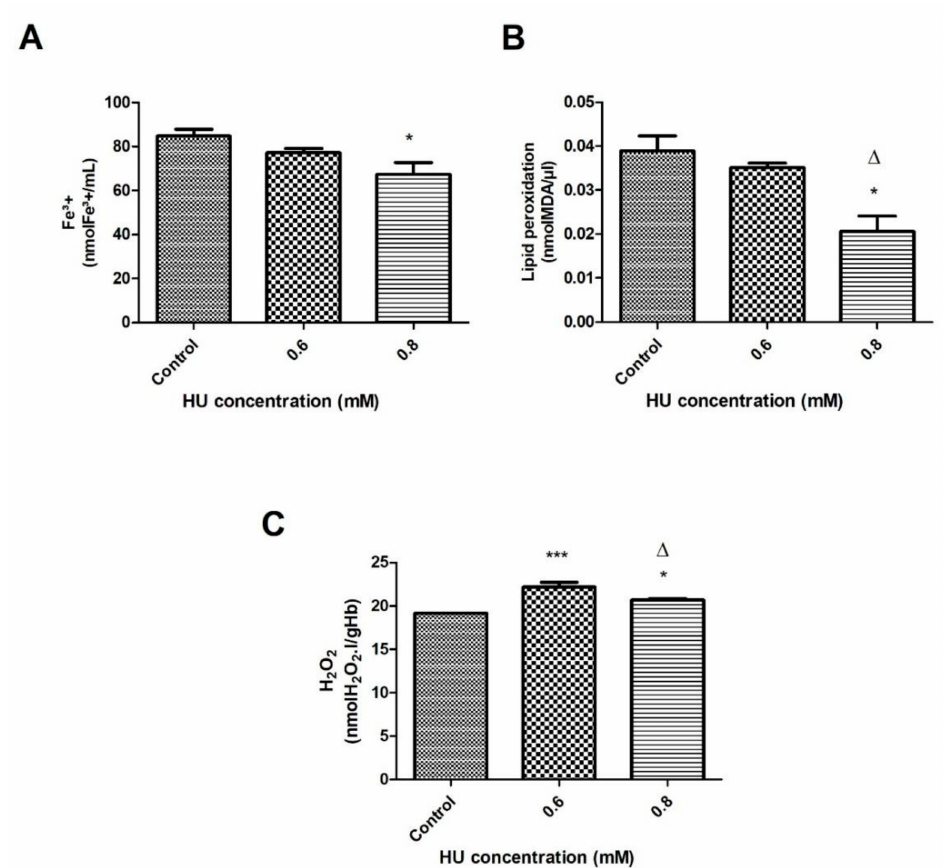
Figure 2. Oxidative stress indicators in the erythrocytes of the control samples that were treated with 0.6 and 0.8 mM HU ( n = 3) for 1 h. ( A ) Fe 3+ was measured in plasma; ( B ) Lipid peroxidation (MDA) was measured in plasma; ( C ) Hydrogen peroxide (H 2 O 2 ) was measured in hemolysate. In all of the cases, * represents a comparison between the controls and the treated groups (* p < 0.05 and *** p < 0.001), while ∆ represents a comparison between the groups treated with 0.6 and 0.8 mM HU ( p <